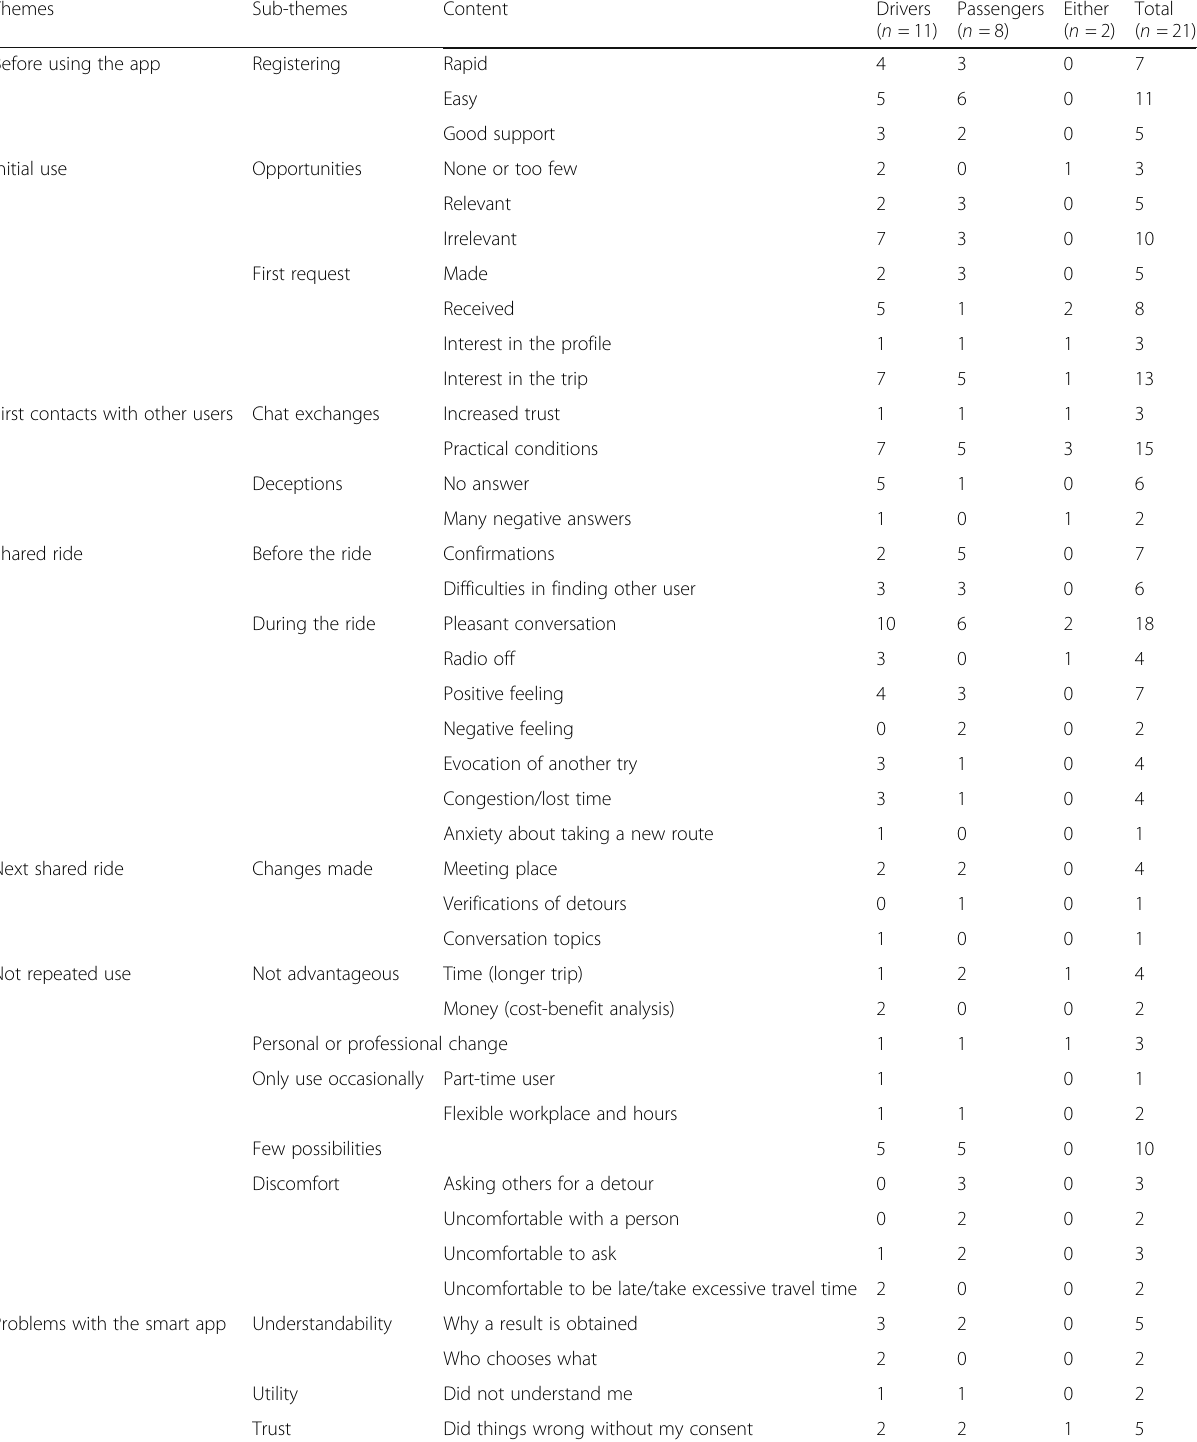
Table 5 Frequency of the appearance of themes in the corpus by role in shared rides (with a single count being added for the presence of the theme in an interview even if the theme appeared many times in the interview)